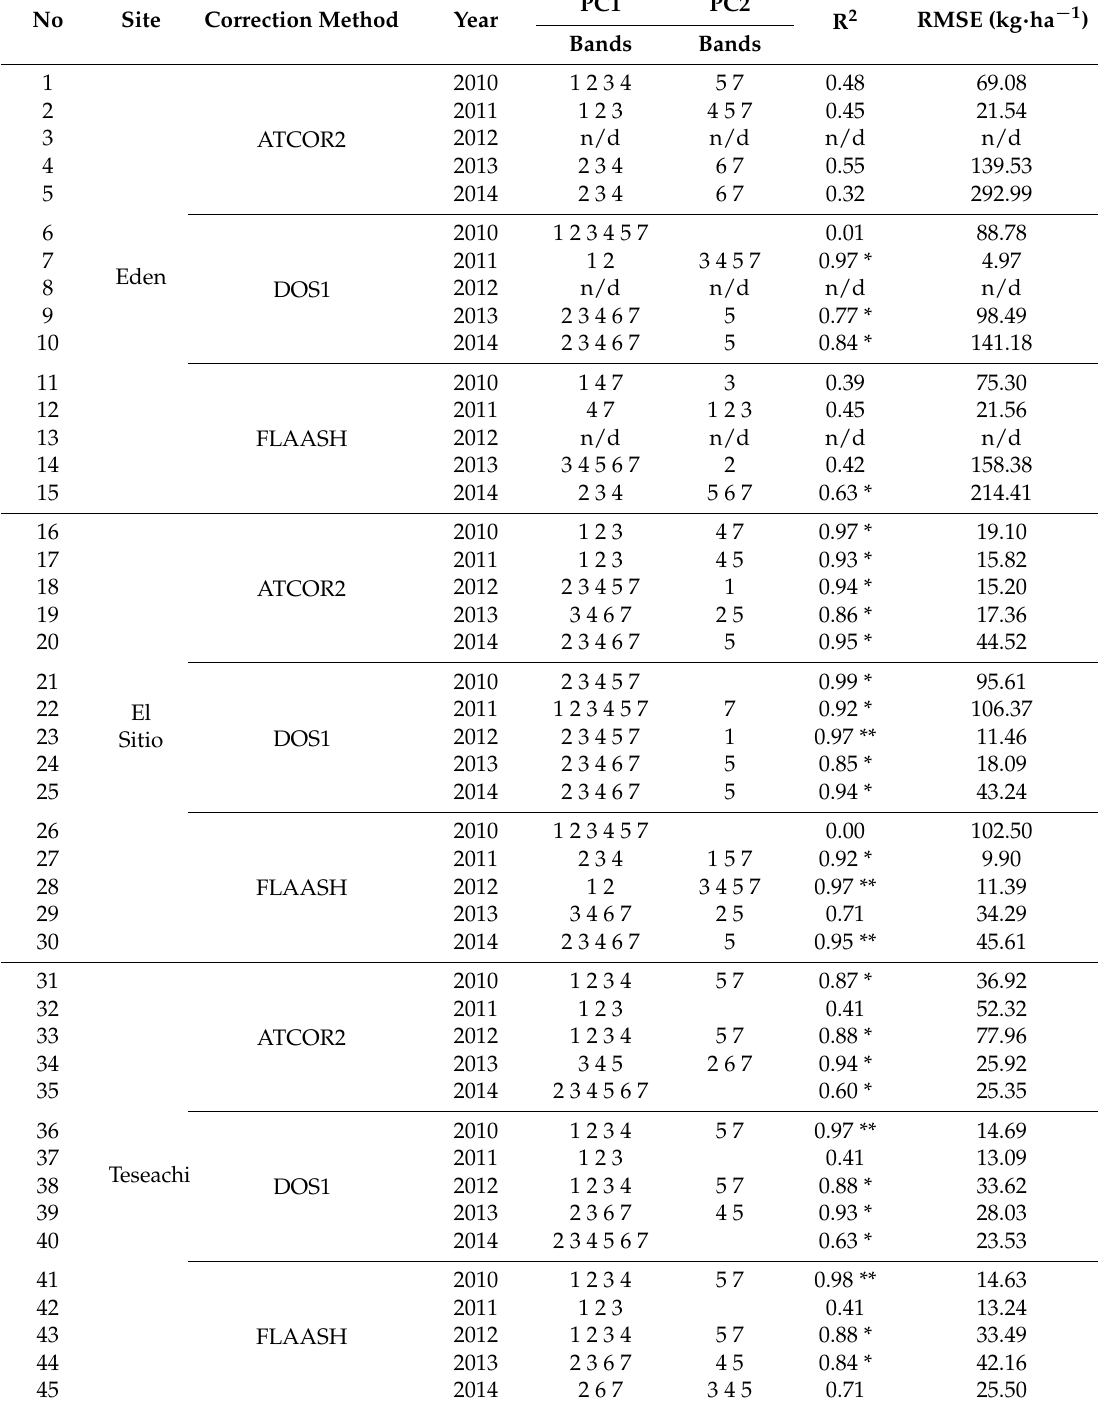
Table 3. Accuracy of the correction methods represented by the values of R 2 and RMSE for biomass estimation in the three PMS and the spectral bands forming the principal